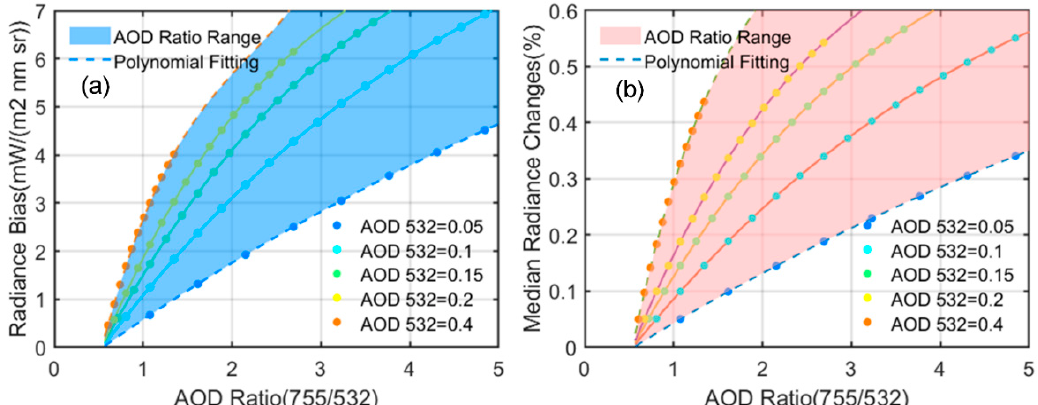
Figure 4. Radiance bias and median radiance changes with different τ 755/532 . ( a ) Dots in different colors mean different AOD at 532 nm. The shaded block indicates the variation range of ∆ r off , and the dashed line indicates the polynomial fitting curves between ∆ r off and τ 755/532 . ( b ) △ r m distribution with different τ 755/532 .